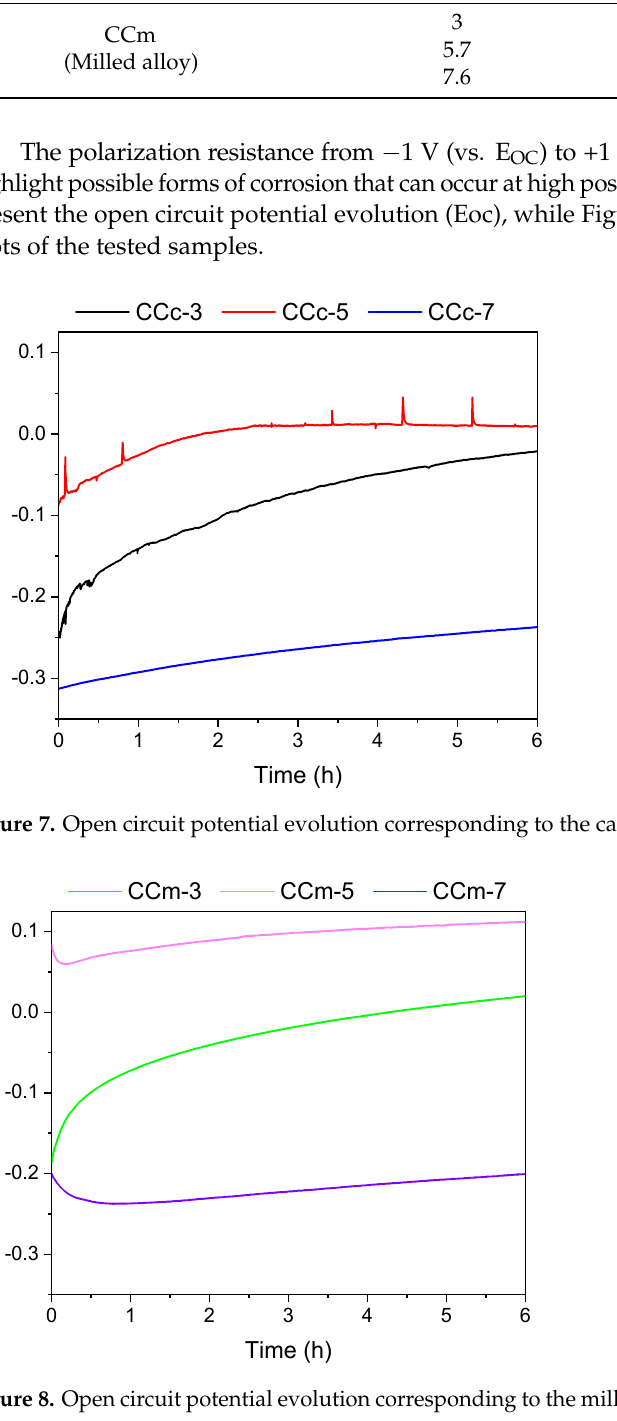
Figure 9. Tafel plots of cast Co-Cr alloy in all testing media. Figure 10. Tafel plots of milled Co-Cr alloy in all testing media.